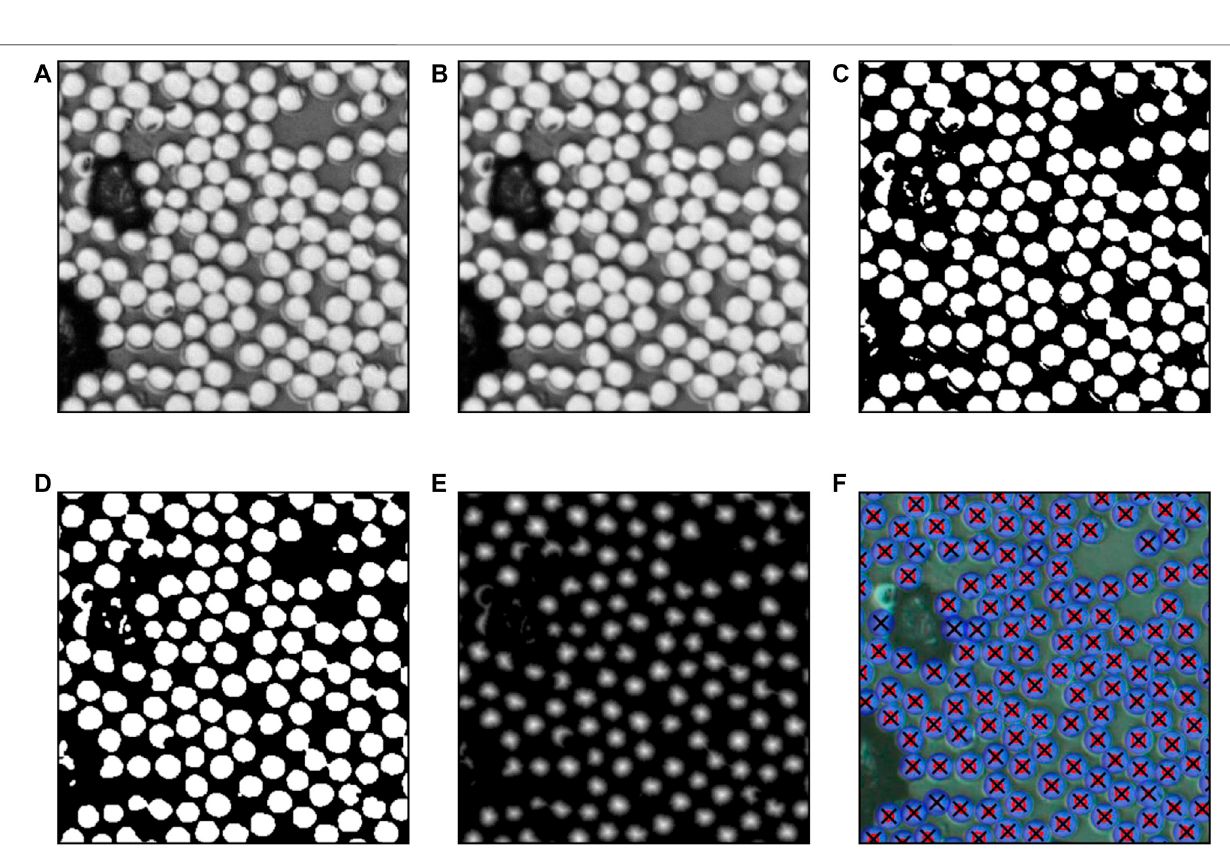
Frontiers in Materials |